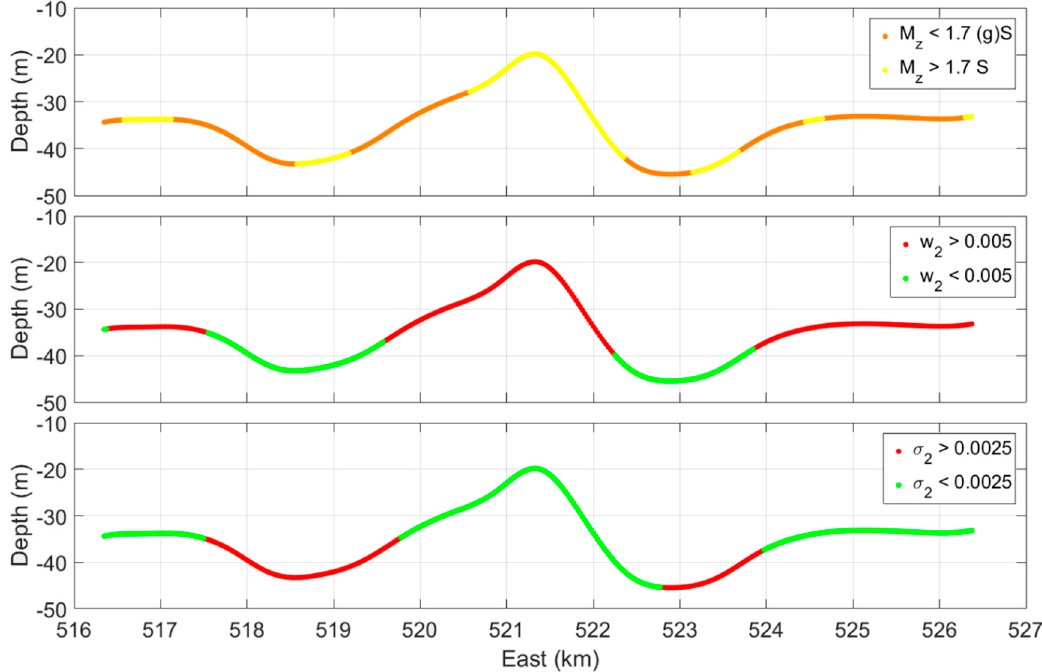
Figure 13. Large scale variations of estimated mean grain size M z ( top ), spectral strength w 2 ( middle ), and volume scattering parameter σ 2 ( bottom ) over Brown Bank structure in eastward direction (results averaged along north axis).